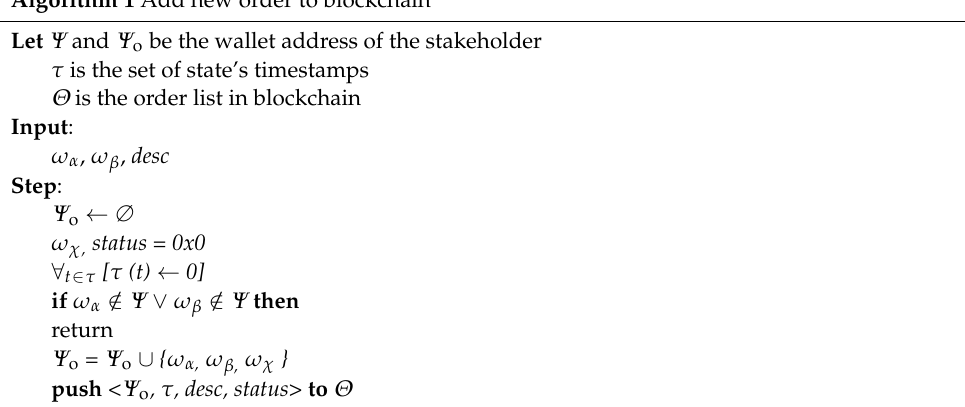
Algorithm 1 Add new order to blockchain